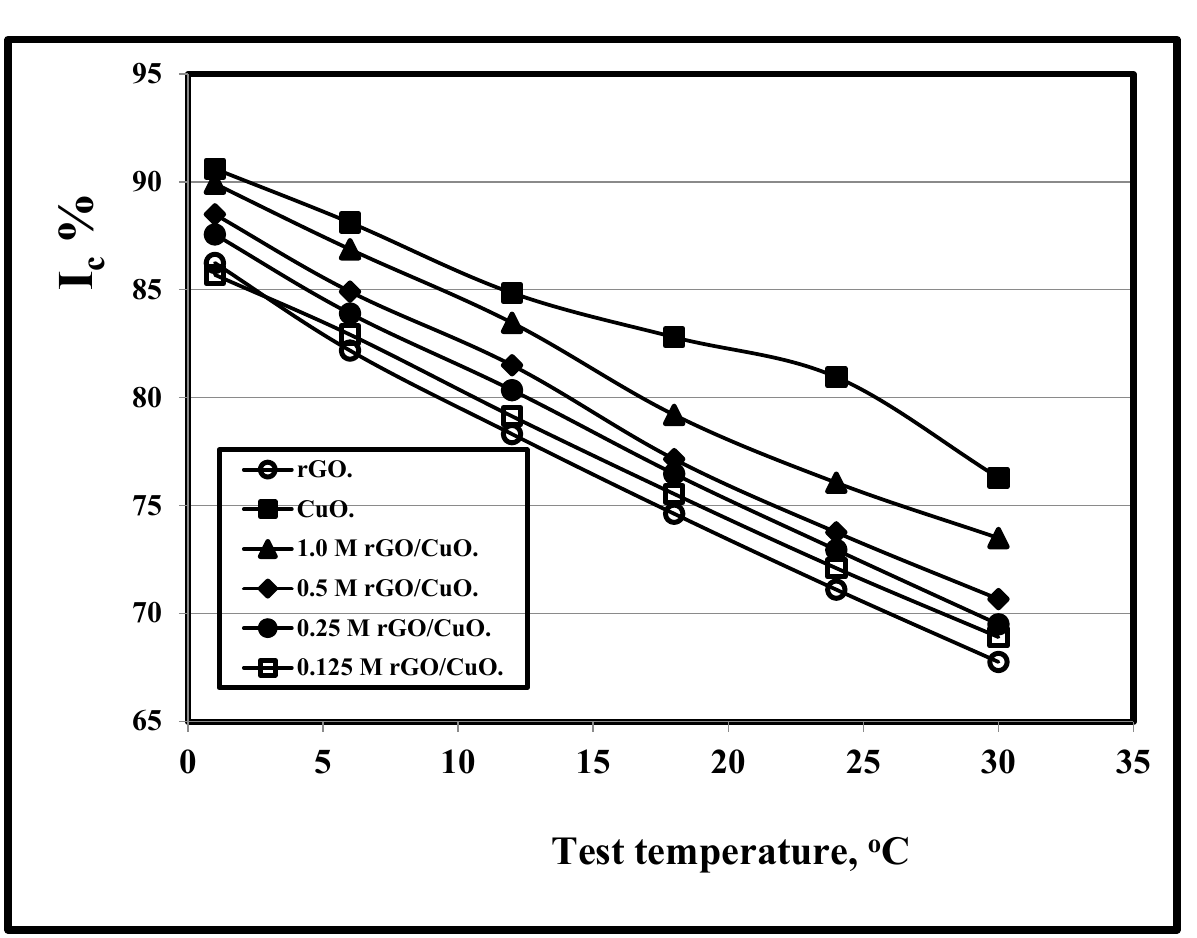
Figure 4. Variation of I c /test period at 500 °C and different rGO molarity concentrations in rGO/CuO.